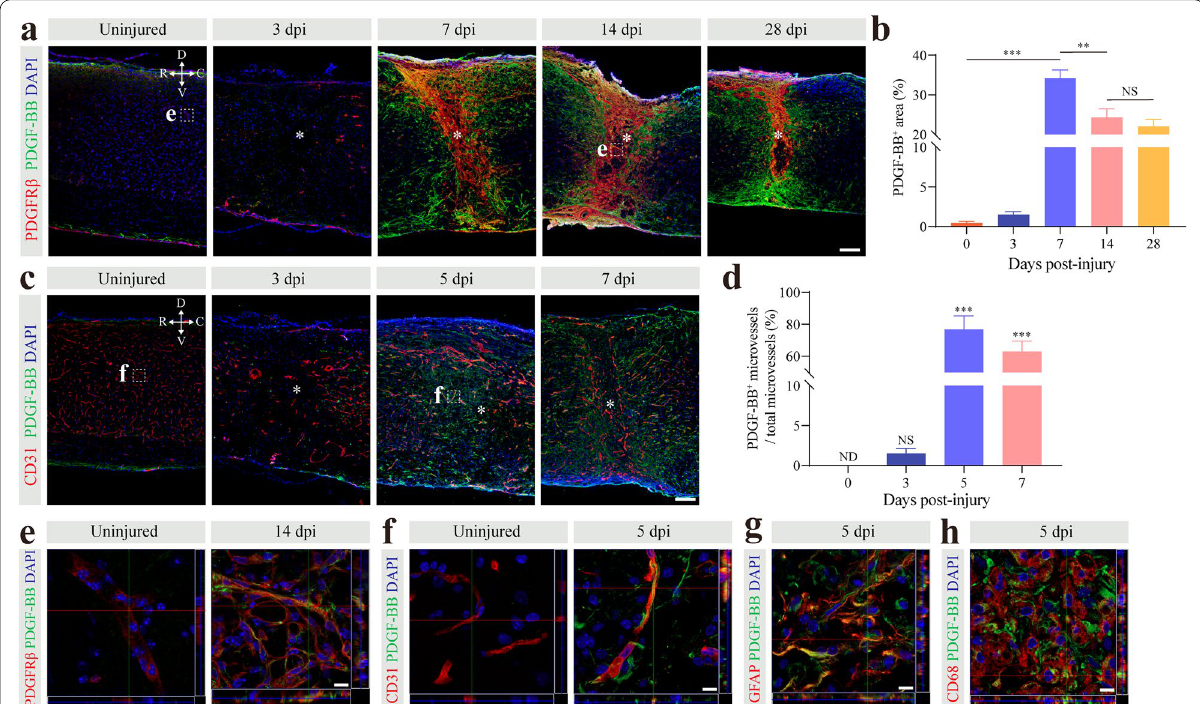
Fig. 3 PDGF‑BB is mainly distributed around the injury core and is of various cellular origins. a Representative immunofluorescence images taken in the spinal cord of uninjured mice and injured mice at 3, 7, 14, and 28 days post‑injury (dpi) showing that PDGF‑BB (green) is predominantly distributed around the lesion core and closely correlated to the spatiotemporal distribution of PDGFRβ (red). b Quantification of the percentage of PDGF‑BB + area. c Representative immunofluorescence images of microvascular endothelial cells (CD31, red) and PDGF‑BB (green) in the spinal cord of uninjured mice and injured mice at 3, 5, and 7 dpi. d Quantification of the percentage of PDGF‑BB + microvessels out of the total microvessels. e , f High magnification z‑stack images of the dotted area in a and c are shown below as the region of interest in e and f , respectively. The lesion core is marked with asterisks. g , h Representative immunofluorescence images of GFAP + astrocytes (red, g ) and CD68 + microglia/macrophages (red, h ) with PDGF‑BB (green) at 5 dpi. The nuclei are stained with DAPI (blue). Data are shown as mean